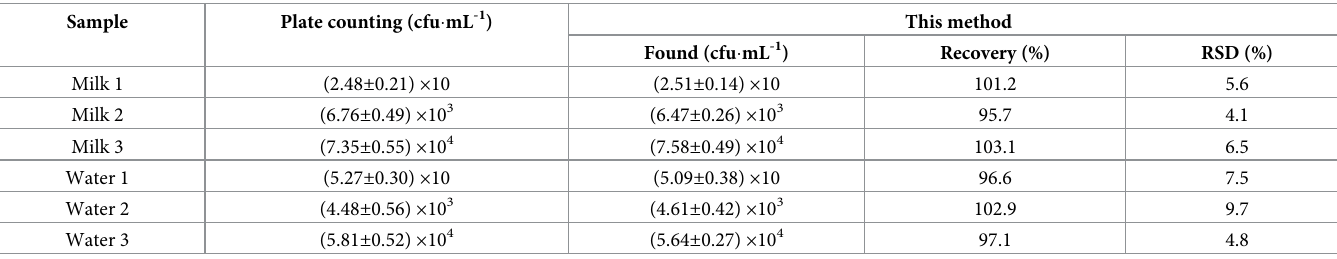
Table 2. Determination of S . Typhimurium in real